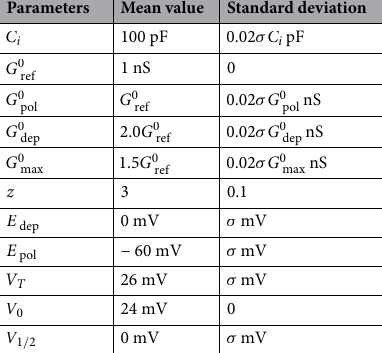
Table 1. Standard cell electrical parameter values used on the model. σ = 3 is applied as the standard deviation on normally distributed values around the mean (stochastic